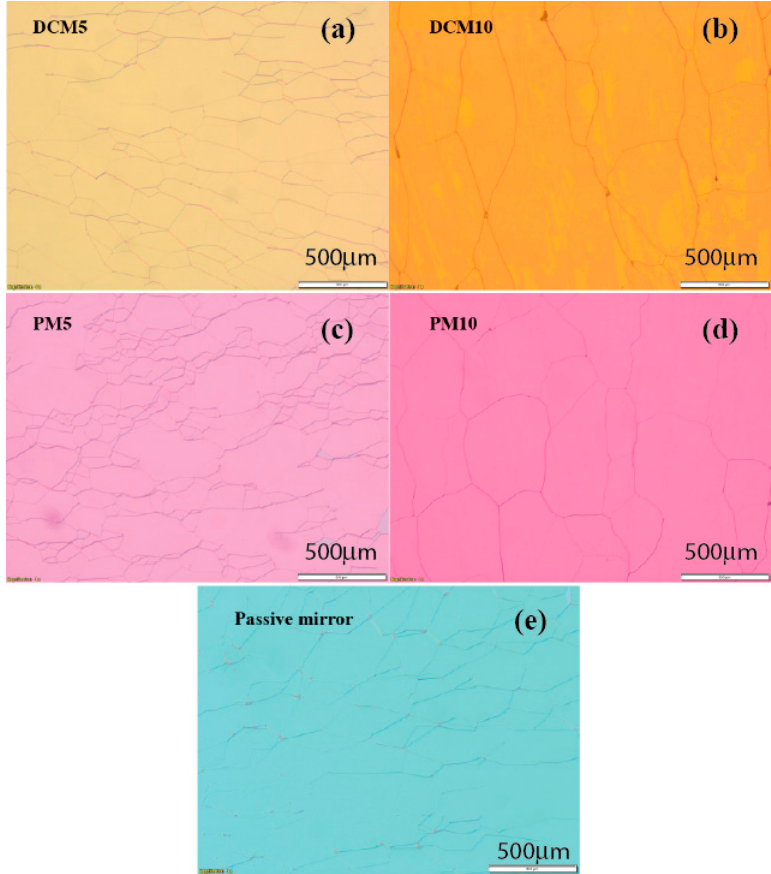
Figure A2. Photomicrographs of the different CLC samples used to build the complex cell architectures ( a – e ). The images have been obtained under crossed polarizers.